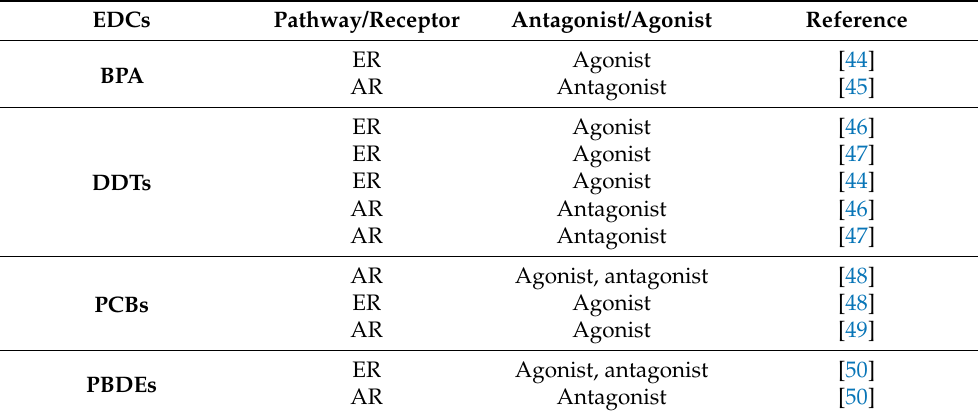
Table 1. The main studies showing the binding of EDCs to androgen receptors (AR) and/or estrogen receptors (ER).